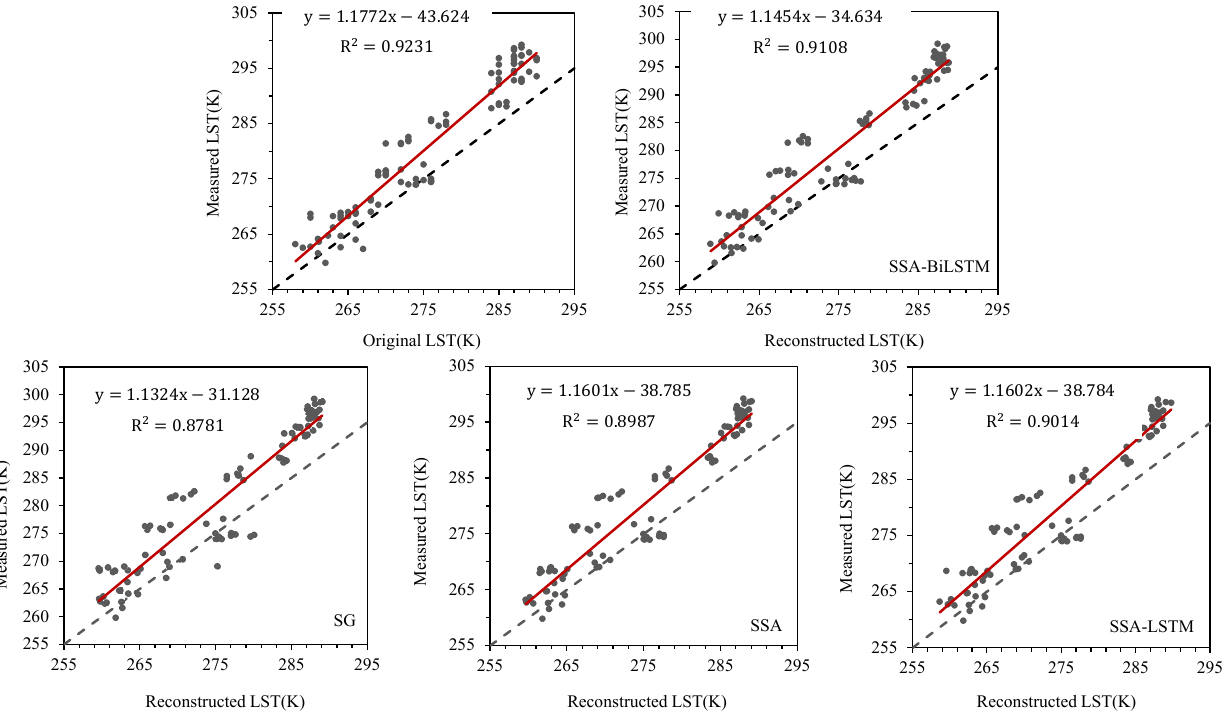
Figure 7. Comparison between LST data after midnight and measured data before (plot on the left side) and after (plot on the right side) reconstruction.